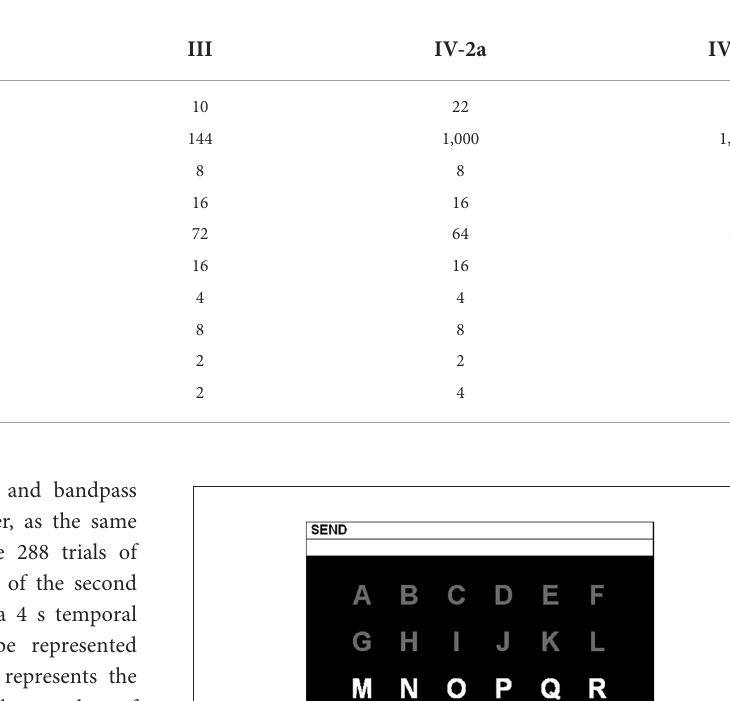
TABLE 2 Hyperparameter setting.